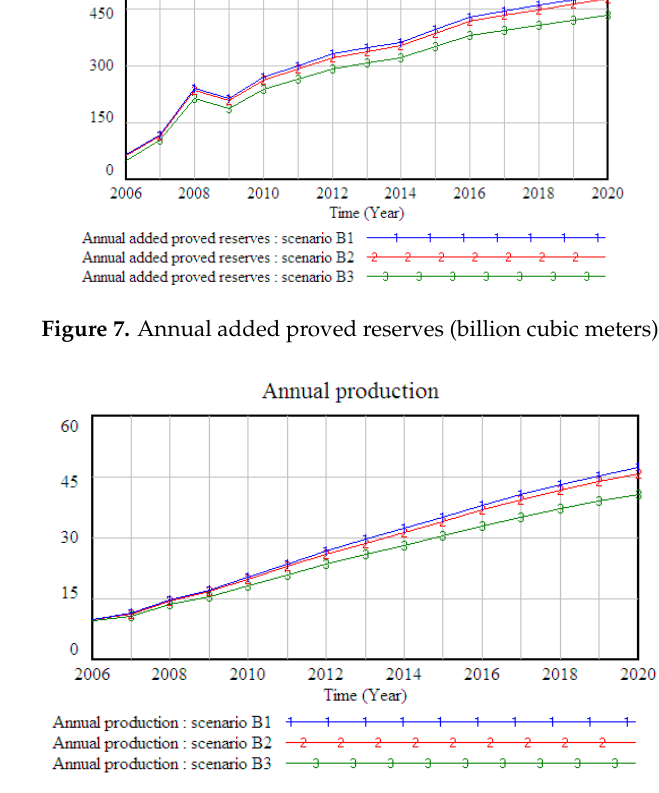
Figure 8. Annual production (billion cubic meters).